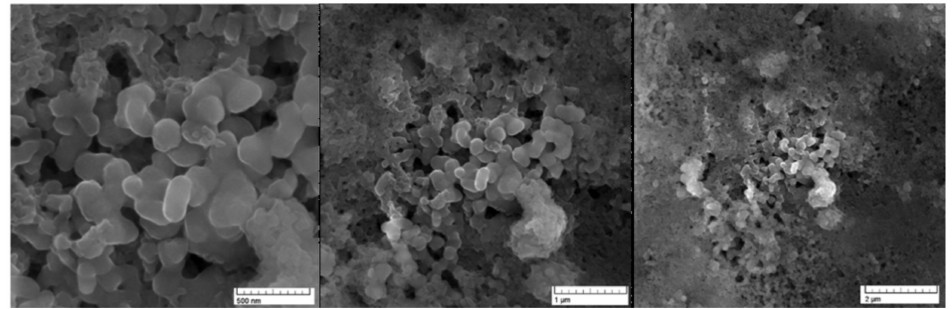
Figure 2. Scanning electron microscopy image for RU-S4 in di ff erent scales: ( a ) scale 500 nm, ( b ) scale 1 µ m, ( c ) scale 2 µ